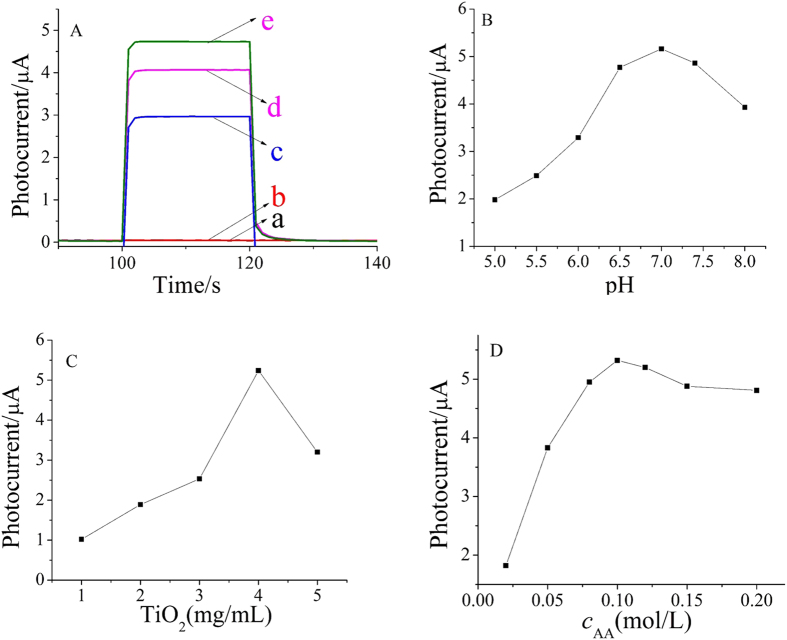
Photocurrent responses of different modified materials (A) effect of pH (B) the concentration of TiO2 (C) and the concentration of AA (D) on the photocurrent intensity. (a) ITO (b) ITO/g-C3N4 (c) ITO/TiO2 nanoparticles (d) ITO/TiO2 nanosheets (e) ITO/g-C3N4/TiO2 composite.